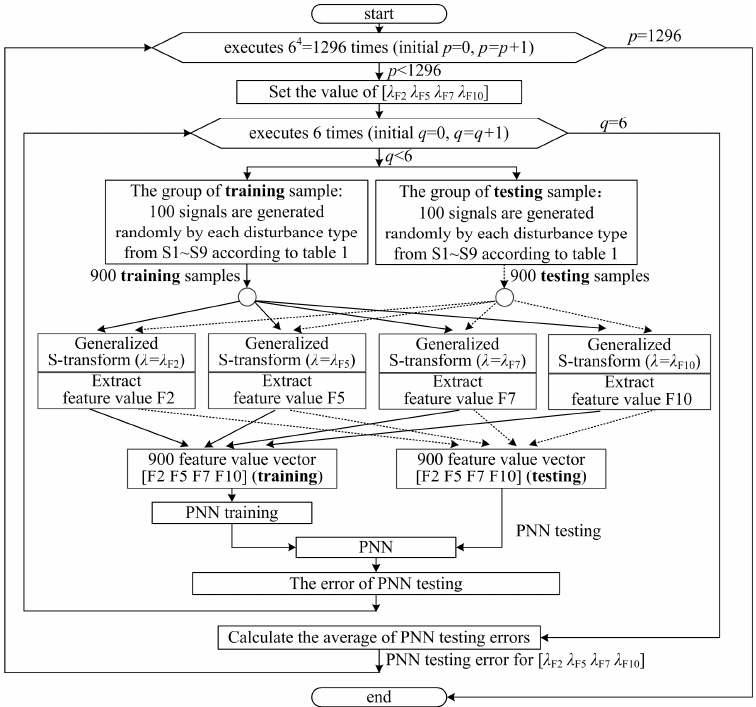
Figure 9. The flow chart for the PNN classification error.